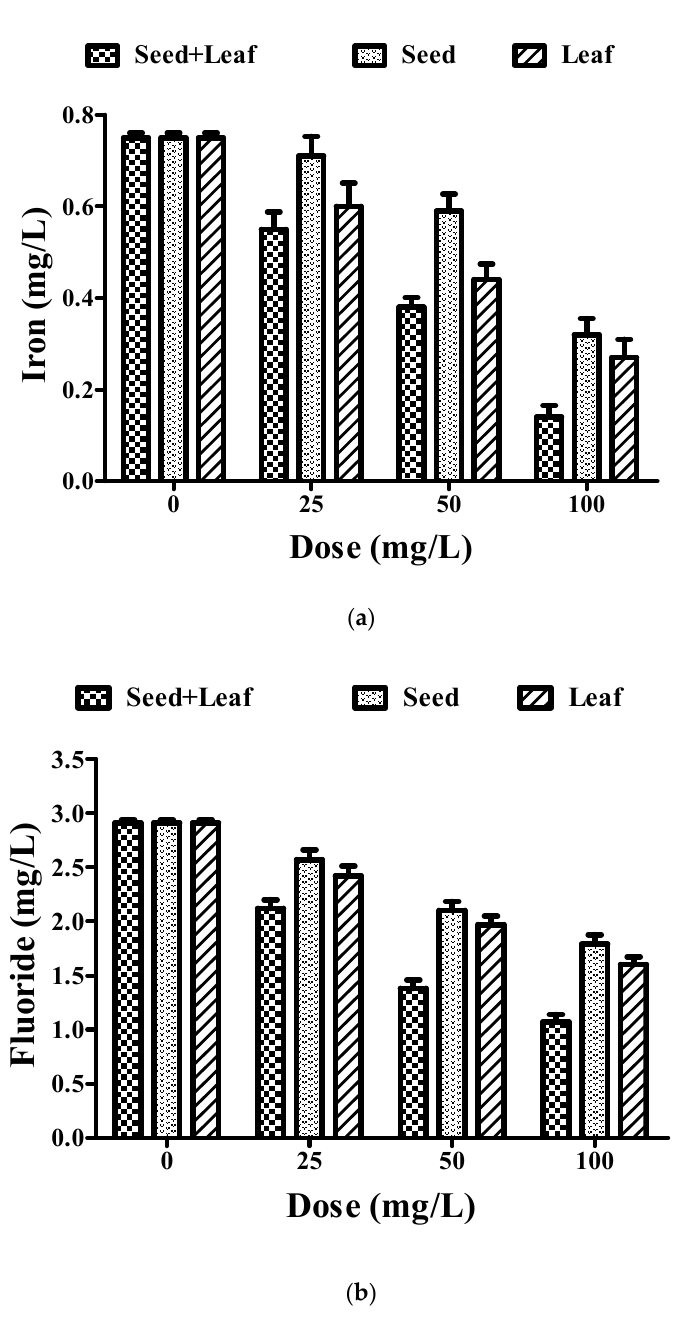
Figure 5. Comparative experimental analysis of combined (seed and leaf) and individual extracts of Moringa oleifera plant on metallic impurity parameters such as ( a ) iron and ( b ) fluoride in groundwater at different doses (25–100 mg/L). Experiments were done three times in triplicates and presented as mean ± SEM.